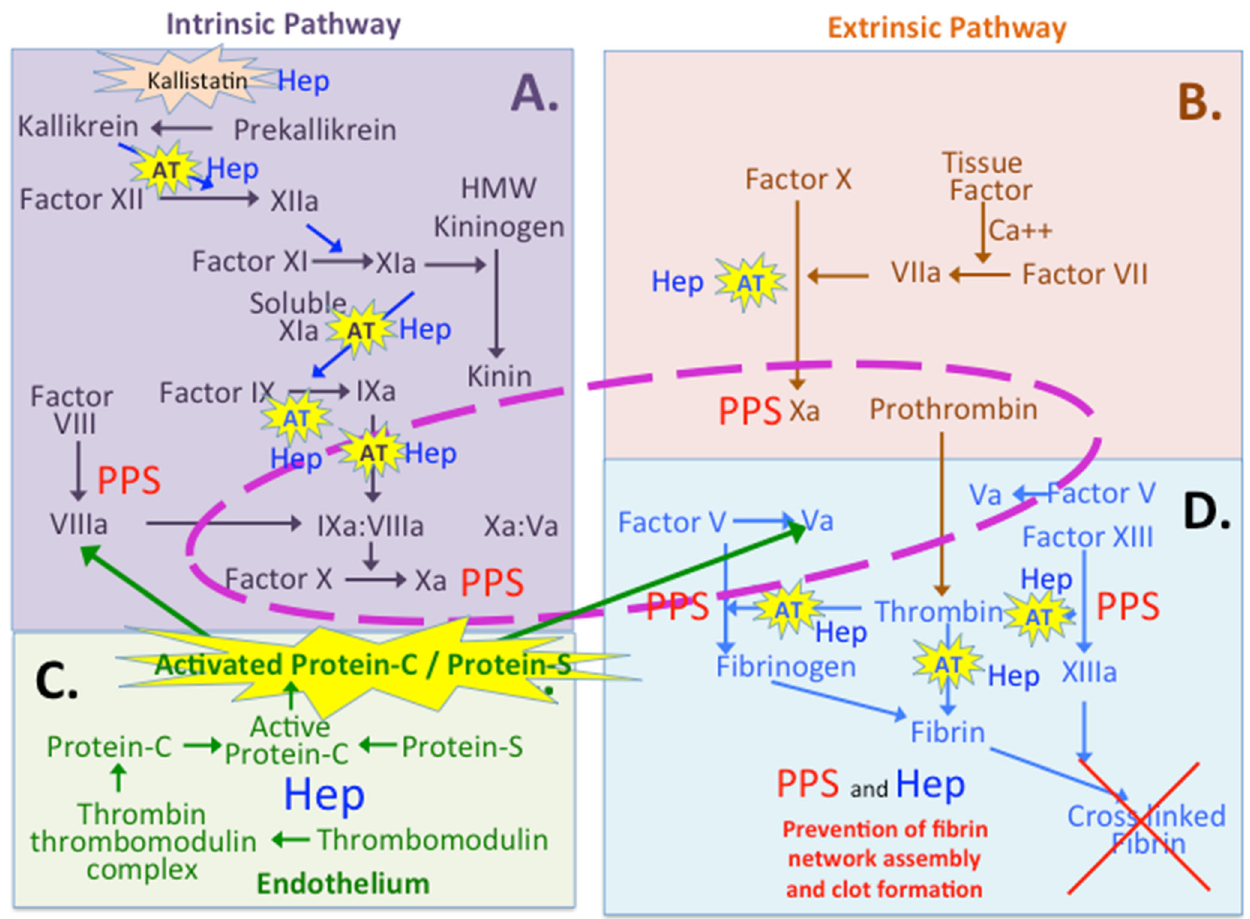
Figure 4. The coagulation cascade that regulates blood clot formation in wound repair and early containment of the wound site. The intrinsic pathway leads to sequential steps which generate Factor Xa ( A ). Factor Xa is also generated by the extrinsic pathway following tissue damage ( B ). Production of coagulation regulatory proteins in the endothelium ( C ). Thrombomodulin is a GAG substituted protein which has important roles in the regulation of the procoagulant proteins Protein C and Protein S. Thrombin and Factor Va have central roles in fibrin network assembly ( D ). The reactions surrounded by the central dotted area are those which occur on the platelet surface.